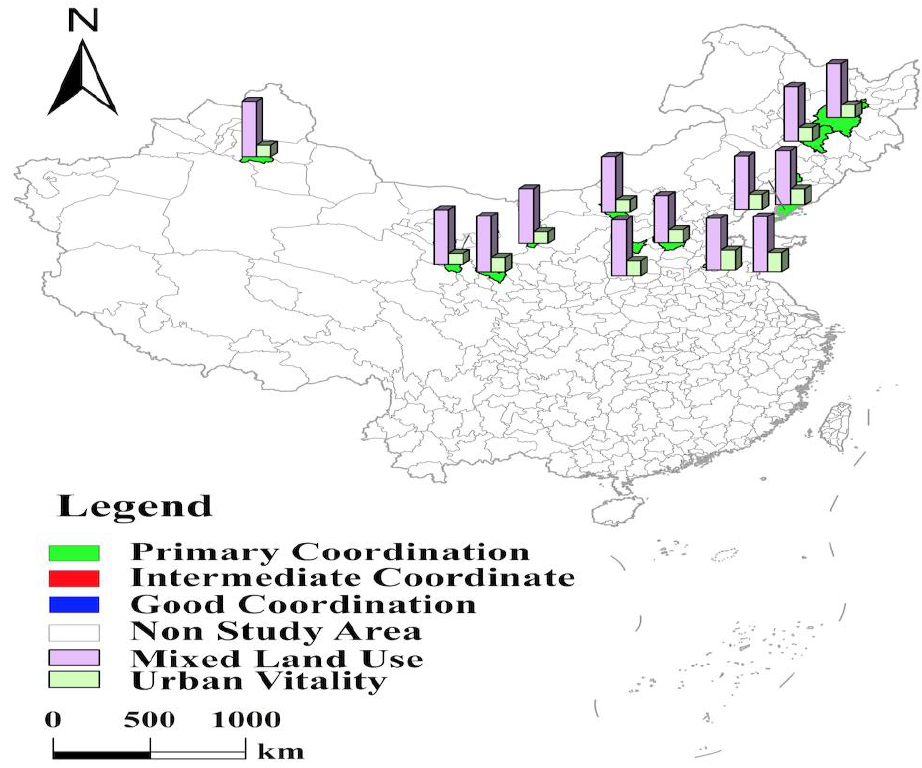
Figure 6. Levels of mixed land use, urban vitality, and coupling coordination in northern part in 35 major cities.